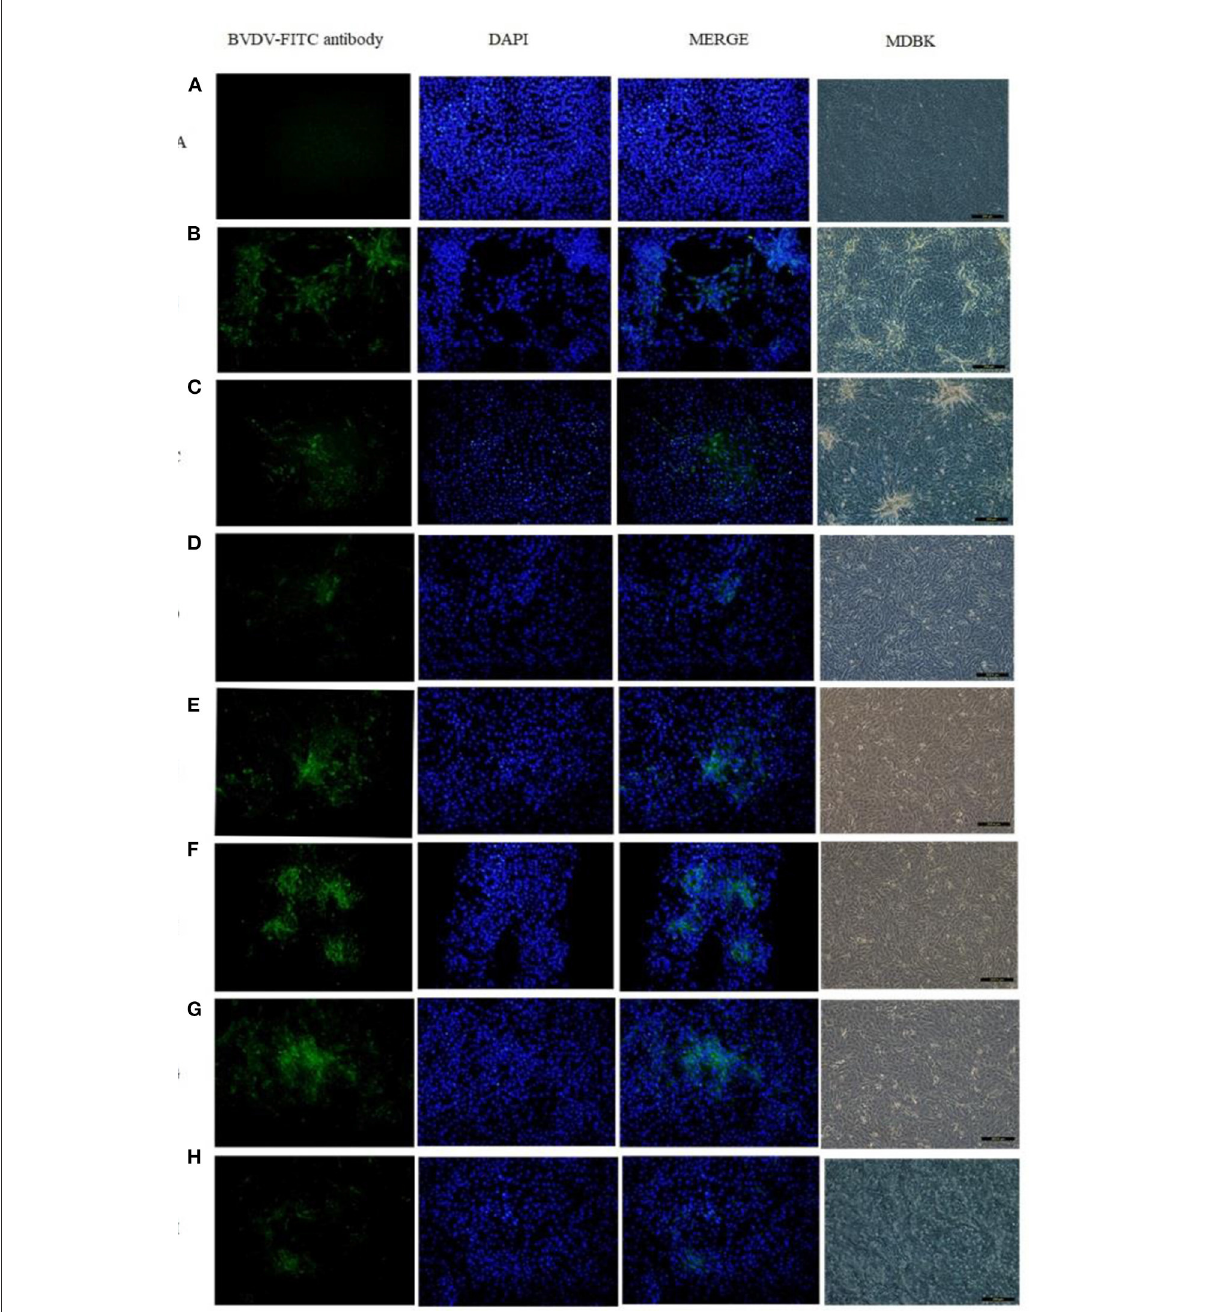
FIGURE3 Total six strains were isolated, only GSLY and NXWZ isolates generated cytopathic effects, the others had no cytopathic effect on cells. All separated cultures were observed under the fluorescence microscope, and green fluorescence appeared in the cytoplasm, (A) : the MDBK cell as negative control, (B) : the cytopathic of NADL strain as positive control, (C) : the cytopathic of GSLY strain, (D) : the non-cytopathic of GSLZ strain, (E) : the non-cytopathic of SXHY strain, (F) : the non-cytopathic of XJFK strain, (G) : the non-cytopathic of NXYC strain, (H) : the cytopathic of NXWZ